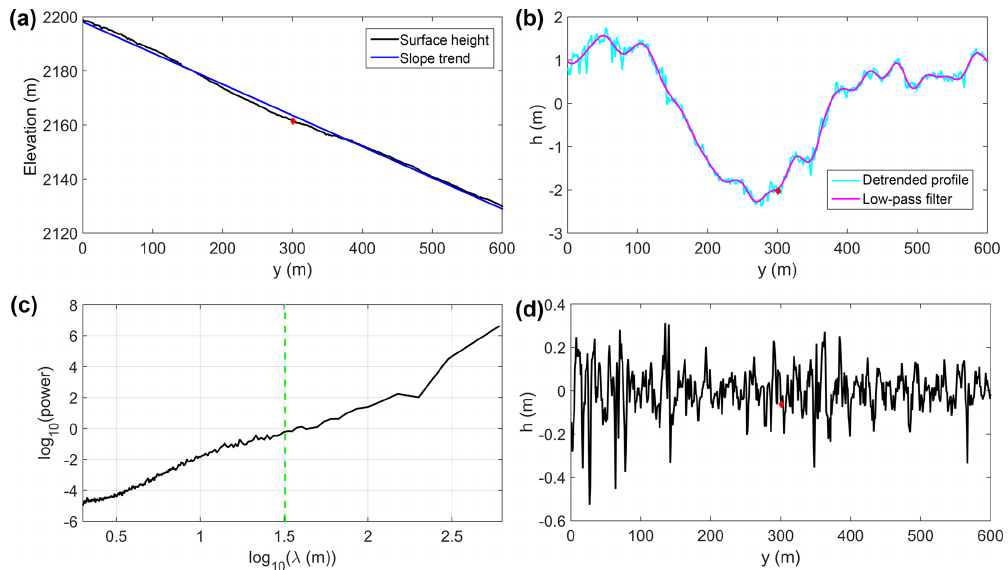
Figure 3. (a) Surface height profile from the September 2016 DEM centred on CG16-1 (red diamond) and a fitted linear trend; (b) detrended profile and low-pass filter according to cut-off wavelength of λ 0 ; (c) log–log power spectrum of the mean detrended profile, with large-scale wavelengths greater than λ 0 (green dashed line) used in the low-pass filtering; (d) filtered profile used in the calculation of momentum roughness length.